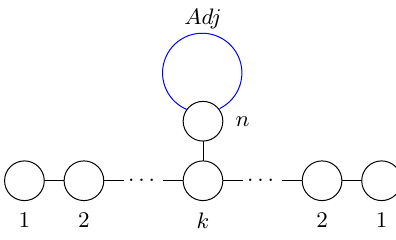
Figure 5 . A series quiver with P